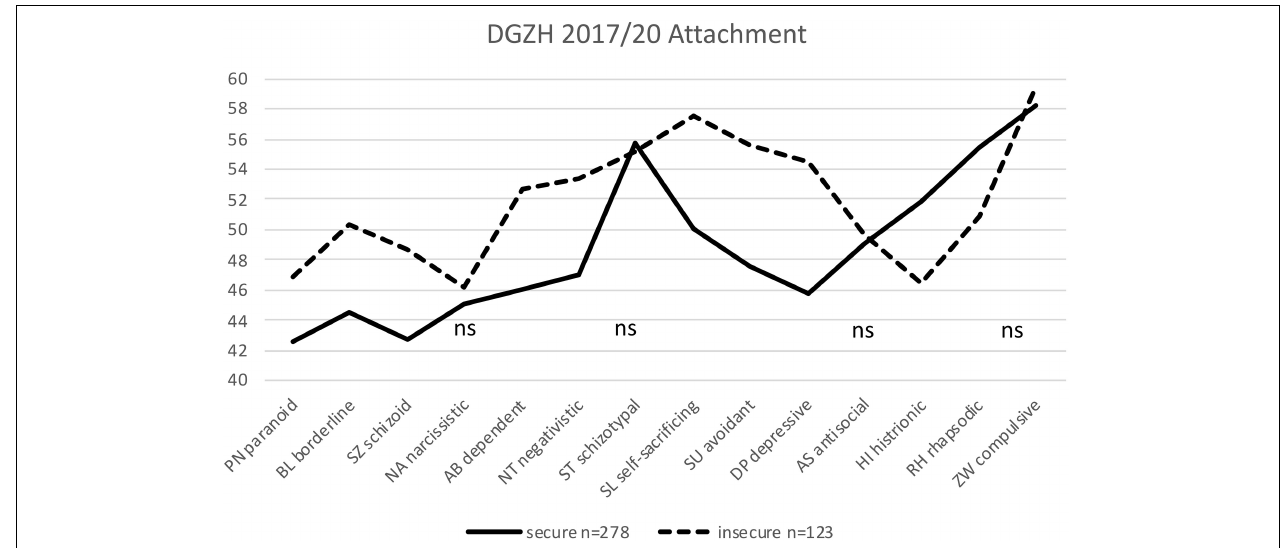
FIGURE 3 | Significant differences between 278 securely and 123 insecurely attached HYP DGZH dentists in 10 of 14 personality styles. The non-significant differences are labeled ns ( t -values are plotted on the y -axis; mean is t = 50; normal range is between t = 40 and t = 60; ns: not